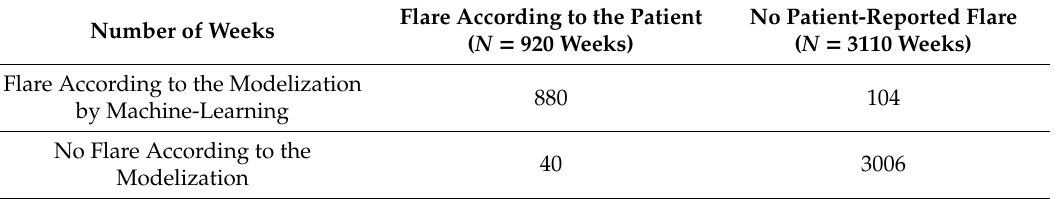
Table 3. Prediction of flares by steps / hour using a Machine Learning approach on pooled analyses (corresponding to 4030 weeks of physical activity overall). Flare According to the Patient No Patient-Reported Flare Number of Weeks ( N = 920 Weeks) ( N = 3110 Weeks) Flare According to the Modelization 880 104 by Machine-Learning No Flare According to the 40 Modelization